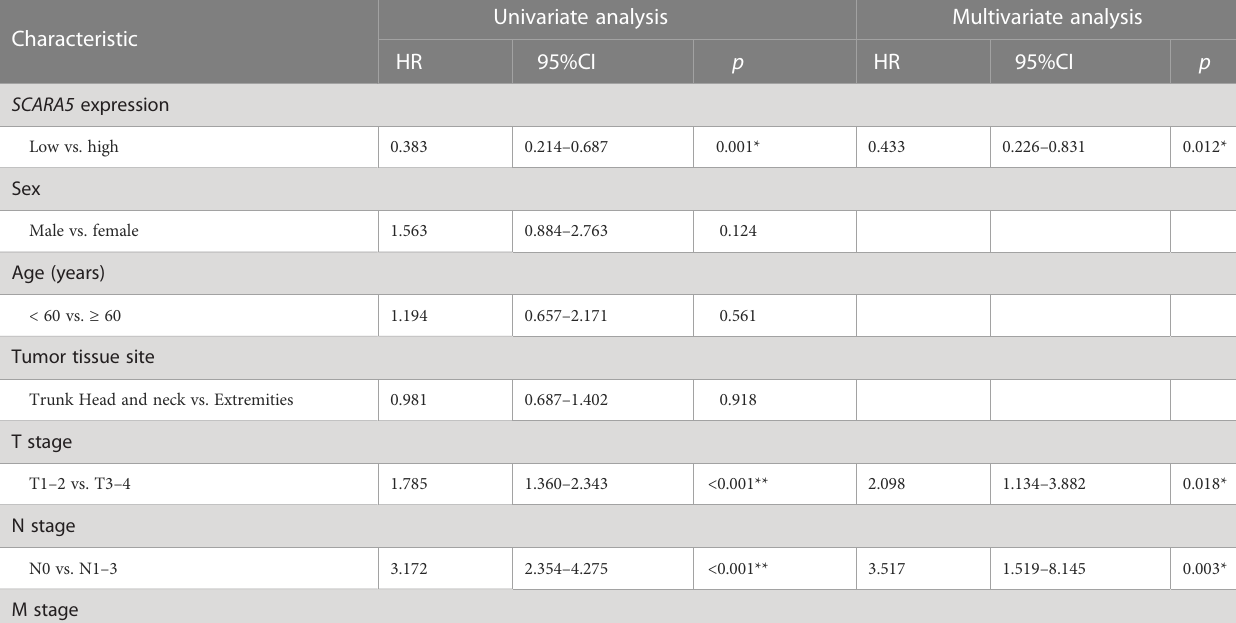
TABLE 5 Univariate and multivariate analysis of prognostic factors of 5-year overall survival in scavenger receptor class A member 5 ( SCARA5 ) patients. Univariate analysis Multivariate analysis Characteristic HR 95%CI p HR 95%CI p SCARA5 expression Low vs.